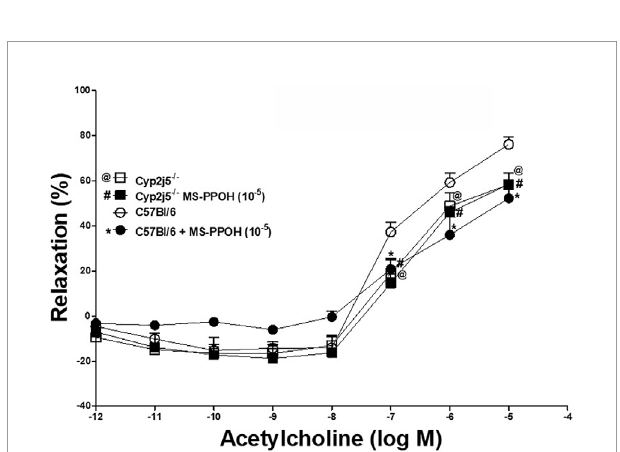
between C57Bl/6 vs. Cyp2j5 − / − mice (at 10 − 5 M ACh, 76.1 ± 3.3 vs . 58.3 ± 5.2, P < 0.05, Figure 2 ).